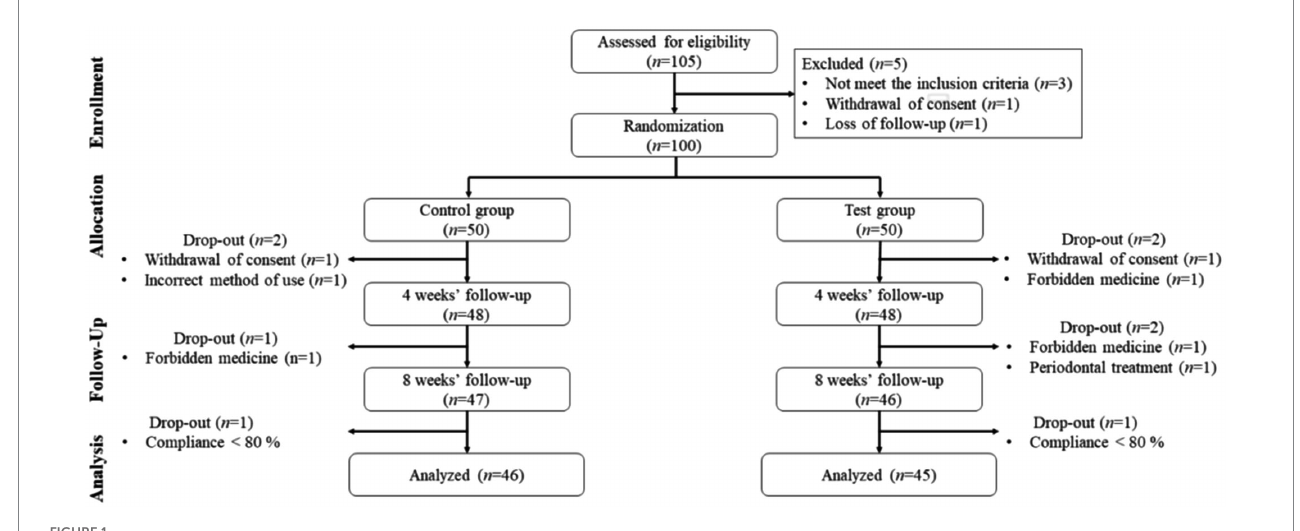
FIGURE 1 Flow chart of the study